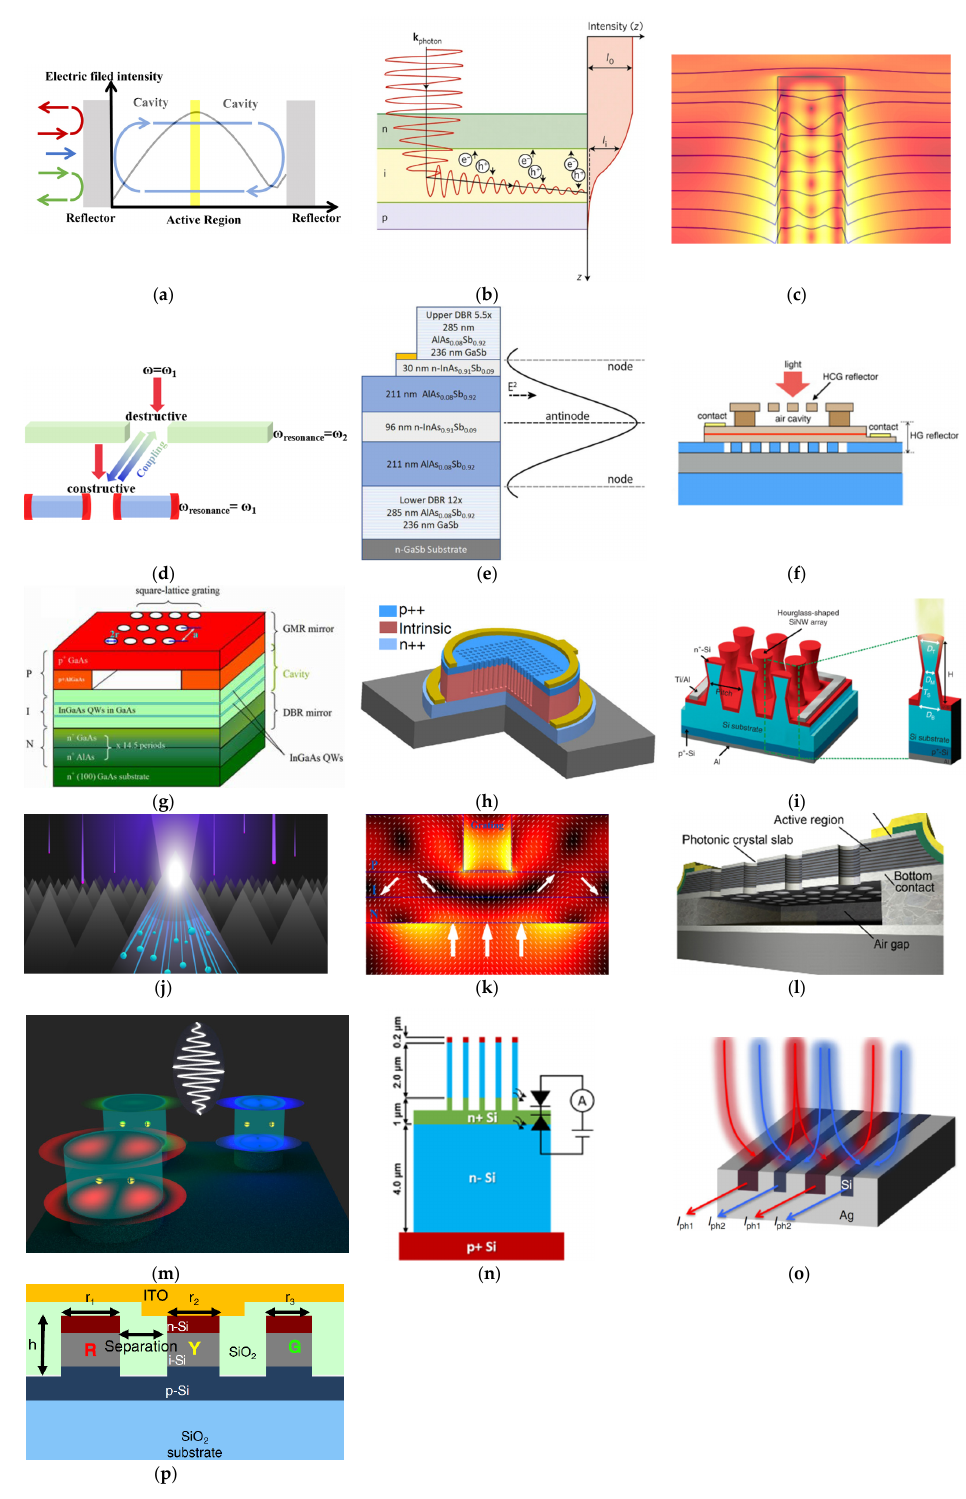
Figure 7. Examples of metasurface assisted resonant photodetectors. ( a ) The basic scheme of resonant cavity-enhanced photodetectors. ( b ) Basic scheme of photo-trapping microstructures assisted photodetector. ( c ) Basic scheme of nanowire waveguide photodetector. ( d ) Basic scheme of Anti-Hermitian nanowire system. ( e ) DBR based RCE-PD. ( f ) HCG-R based RCE-PD. ( g ) PCS-R based multi-wavelength RCE-PD. ( h ) 2D hole array assisted SOI photodetector. ( i ) Whispering gallery mode based hourglass Silicon nanowire photodetector. ( j ) Black Silicon photodetector. ( k ) Guided mode resonance-based InGaAs photodetector. ( l ) Photonic crystal slab-based MQW photodetector. ( m ) Silicon nanowire photodetector. ( n ) Vertically stacked photodetector. ( o ) Anti-Hermitian nanowire photodetectors. ( p ) Anti Hermitian nanorod color sensor. Lai et al. demonstrated an RCE-PD structure consisting of a bottom GaAs/AlAs DBR, a cavity with InGaAs/GaAs multiple quantum wells (MQWs) for light absorption and a top mirror of sub-wavelength grating (Figure 7g). With a single layer serving as a grating and also a waveguide, the sub-wavelength grating exhibits wide-band high-reflectivity based on the guided-mode resonance (GMR) effect [40]. Benefiting from its much thinner thickness and flexibility during device processing, the reflector using GMR effect has been implemented in many photonic devices instead of conventional DBR mirror. By changing the fill factor of the GMR grating, the effective cavity length of RCE-PDs can be varied, so the resonant wavelength can be selected post growth. 4.2. Photon-Trapping Microstructures Assisted Photodetector As shown in Figure 7b, photon-trapping microstructures extend the photon lifetime inside the active region through whispering gallery mode, total internal reflection, pho- tonic crystal slab lateral mode, gradient refractive index, and guided mode resonance. Gao et al. introduced 2D nanohole array into SOI (Silicon on Insulator) planar Silicon photodetector (Figure 7h). The nanohole arrays couple normally incident electromagnetic waves into an ensemble of lateral collective modes propagating along the active region, extending the absorption length by 13 times. The nanohole array assisted Silicon photo- detectors achieve an EQE of 50% and an impulse response time of 30 ps at 850 nm [41], which is suitable for high-speed optical communication. Kim et al. developed Silicon photodetectors (Si PDs) based on a hourglass-shaped nanowire structure, with improved photoresponse in the NIR-SWIR (Short Wavelength Infrared) region. As shown in Figure 7i, the upper, inverted nanocone of the nanowires in- creases absorption probability by extending the dwell time of NIR-SWIR photons via the gen- eration of whispering-gallery-mode (WGM) resonances, whereas the lower nanocone, with its low reflectance, reabsorbs the light incident from surrounding nanowires. When integrated